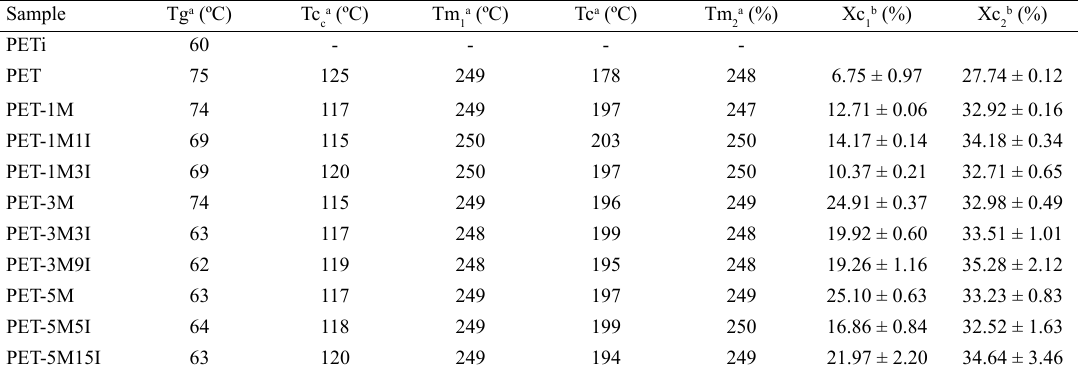
Table 1. Glass transition temperature (Tg), cold crystallization temperature (Tc 1 st